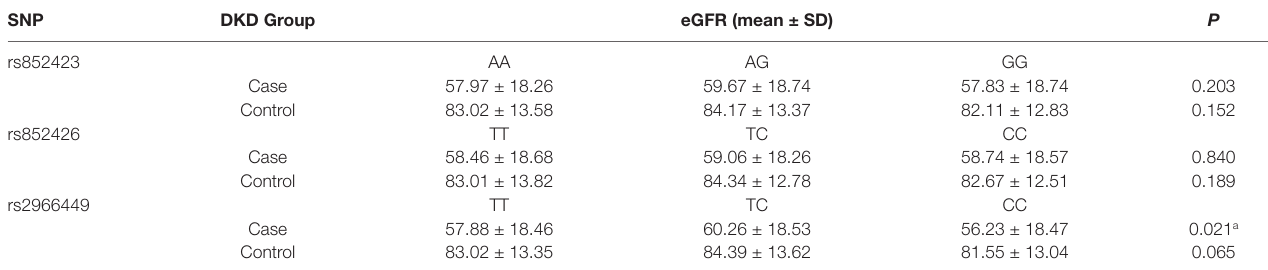
TABLE 4 | Comparison of eGFR among the genotypes of